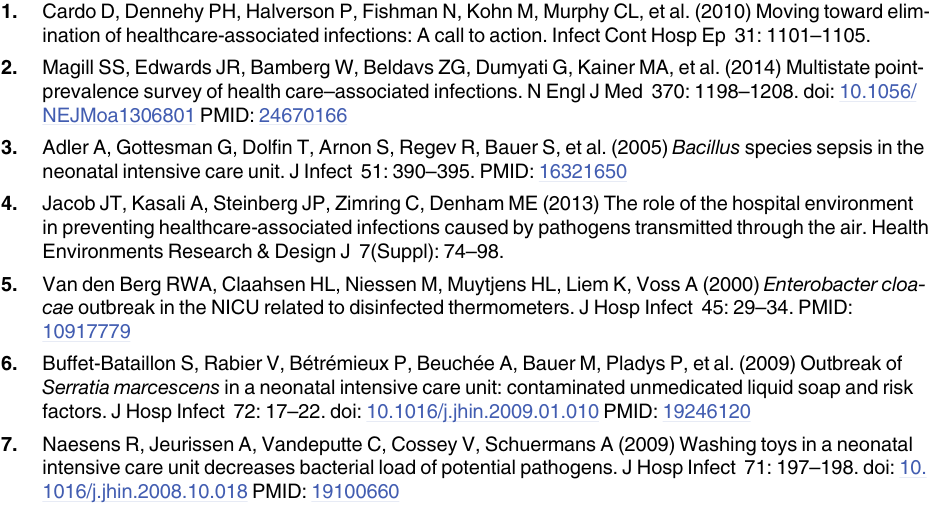
S4 Fig. Coefficient of determination for the linear correlation between concentrations in two simultaneously sampled baby rooms (B10 and B11) for a nine-day period. The results include 5-min means of small (0.3 – 0.5 μ m) and large ( > 10 μ m) particle number concentra- levels. tions, and CO 2 (TIF) S5 Fig. Comparison of individual contributions to the total particle number concentration (TPN) in the baby rooms from three sources: Indoor (within-room) emissions, indoor (near-room) emissions, and outdoors. Individual source contributions to the total TPN were calculated in the same fashion as explained in relation to Fig 6. (TIF) S1 File. Nurses ’ station and HVAC filter maintenance. S1 Table. Adjustment factors obtained from optical particle counter (OPC) side-by-side tests with a reference instrument OPC3. 1